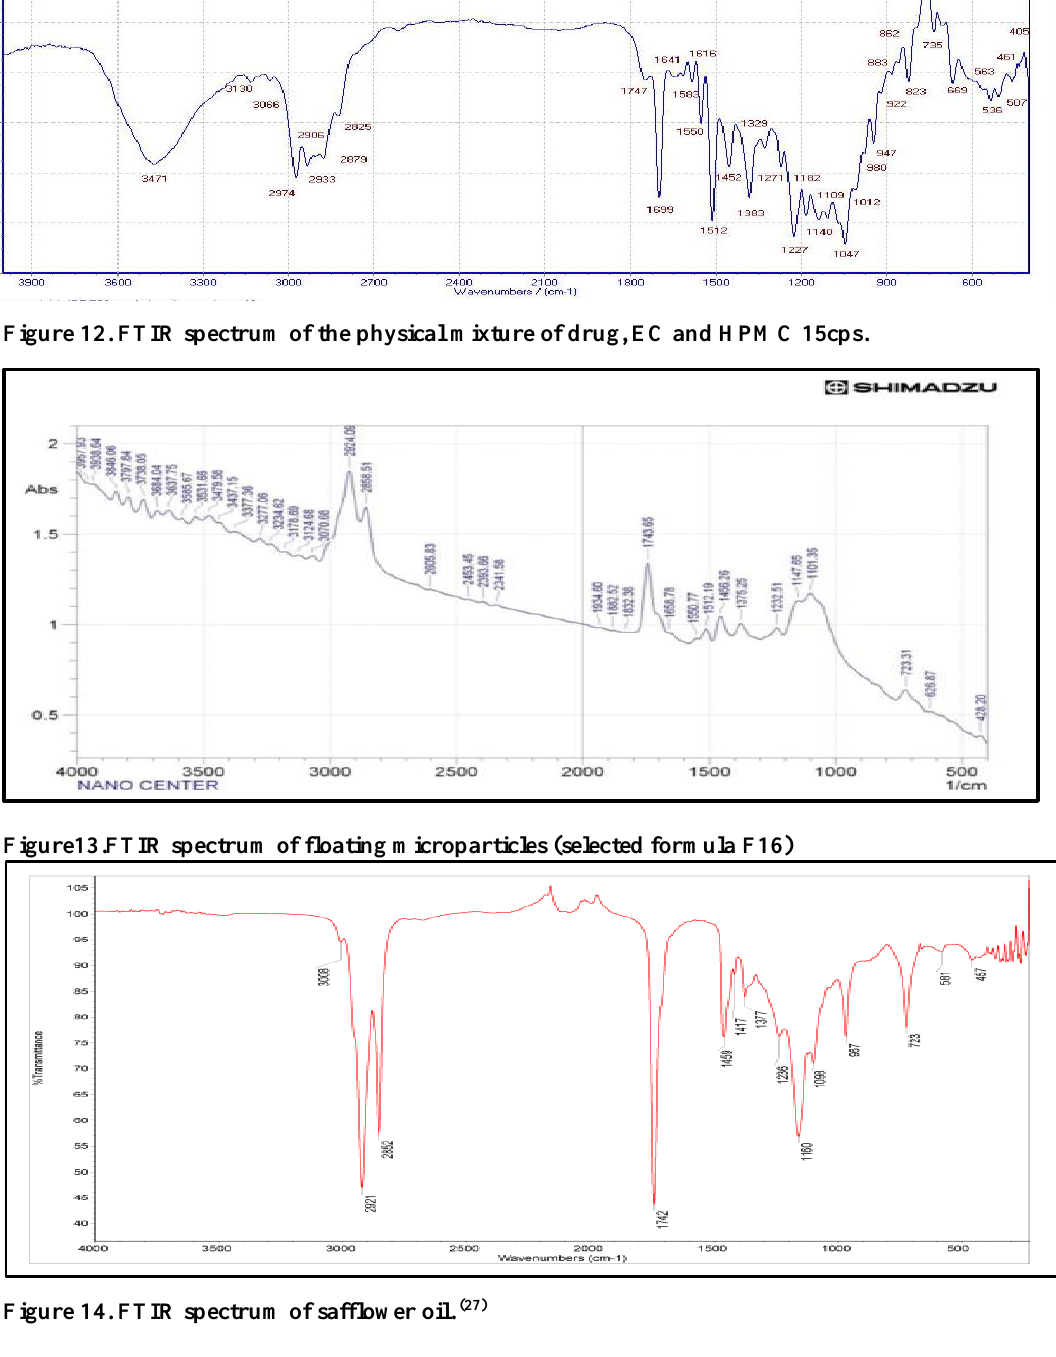
through the numerous distinctive peaks as shown in figure 15 (27) .The XRD of F7 and F16 showed disappearance of the characteristic peaks of pure ITZ as shown in figure 16 and 17 indicated that ITZ incorporated into the polymer matrix that was in the amorphous state (30)